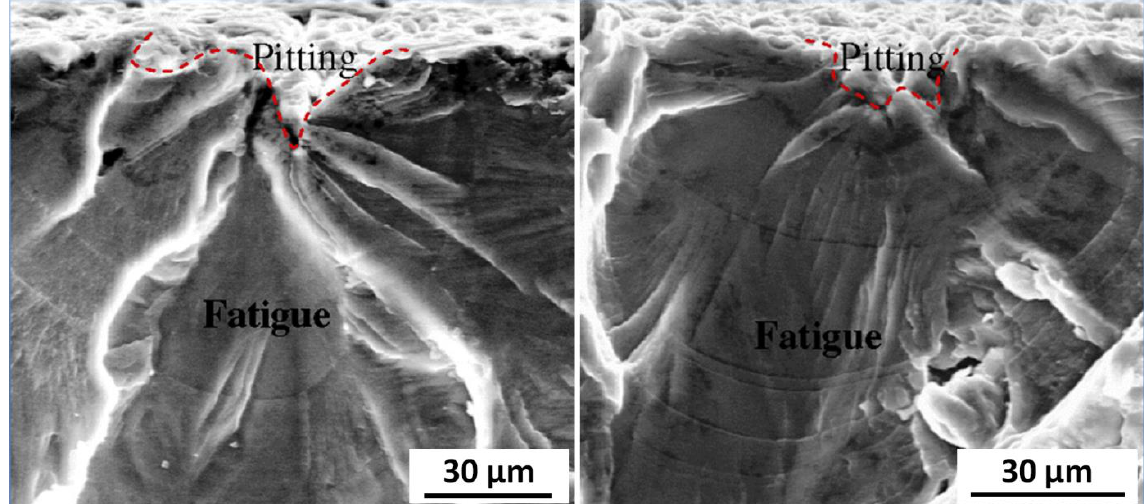
Figure 8 . Scanning Electron Microscope (SEM) secondary electron fractographs of fatigue cracking nucleating from etch pits on AA 7050-T7451 coupon surfaces. The dashed red outlines indicate the interfaces between the pits and the beginning of fatigue crack growth [29].